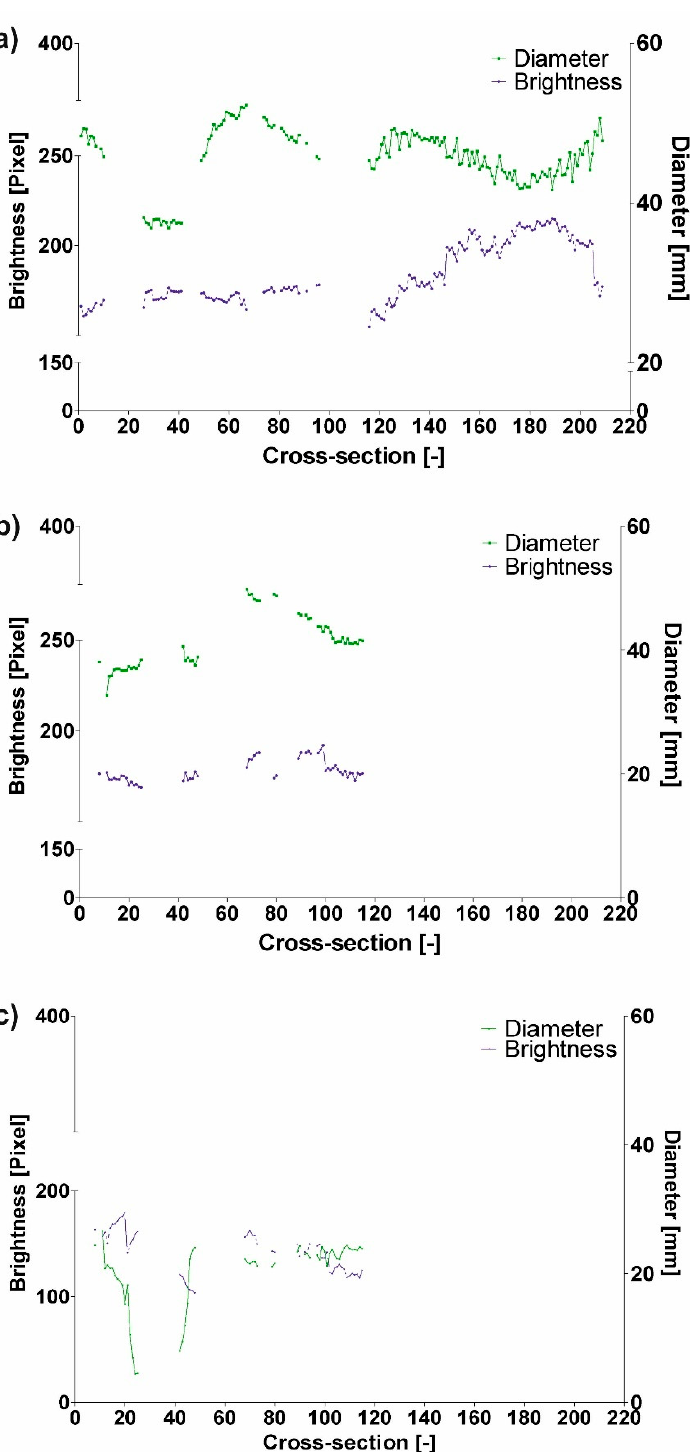
Figure 5. Comparison of brightness and D F for patient 1 (P1): ( a ) Common duct, ( b ) true duct, and ( c ) false duct p > 0.05.